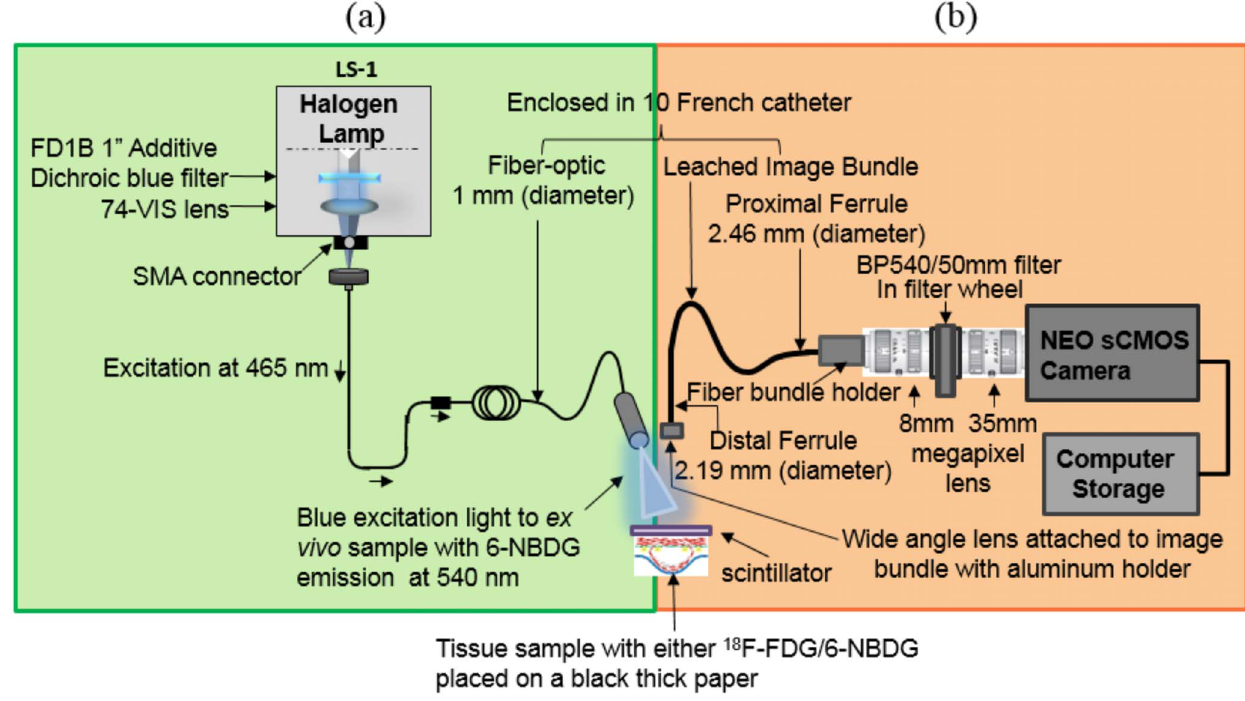
Figure 1. Schematic diagram of the dual-modality fiber-optic imaging system. The catheter fluorescence imaging (CFI) system combines components shown in (a) and (b) including a 540 nm filter placed in a filter wheel to detect glucose probes such as 6-NBDG fluorophore. Scintillating screen is removed during the fluorescence measurement. The catheter radionuclide imaging (CRI) system is shown in (b) to detect 18 F-FDG radionuclide when the CFI light is turned off, no emission filter is in the optical path, and a scintillating screen is used in front of the wide-angle lens. The novel system was placed inside a light-tight black box to prevent any ambient light.